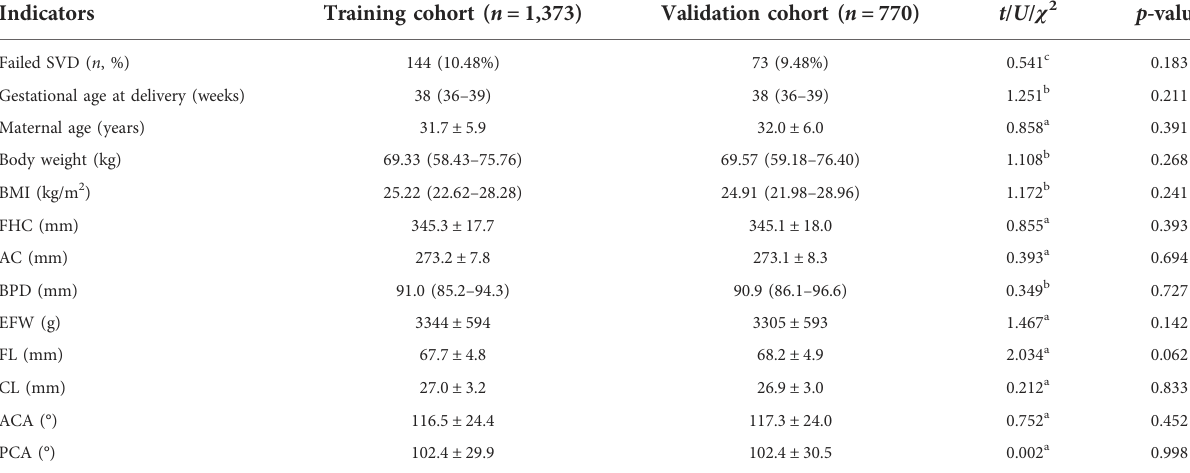
TABLE 1 Comparisons of maternal characteristics and antepartum ultrasound parameters between the training and validation cohorts.